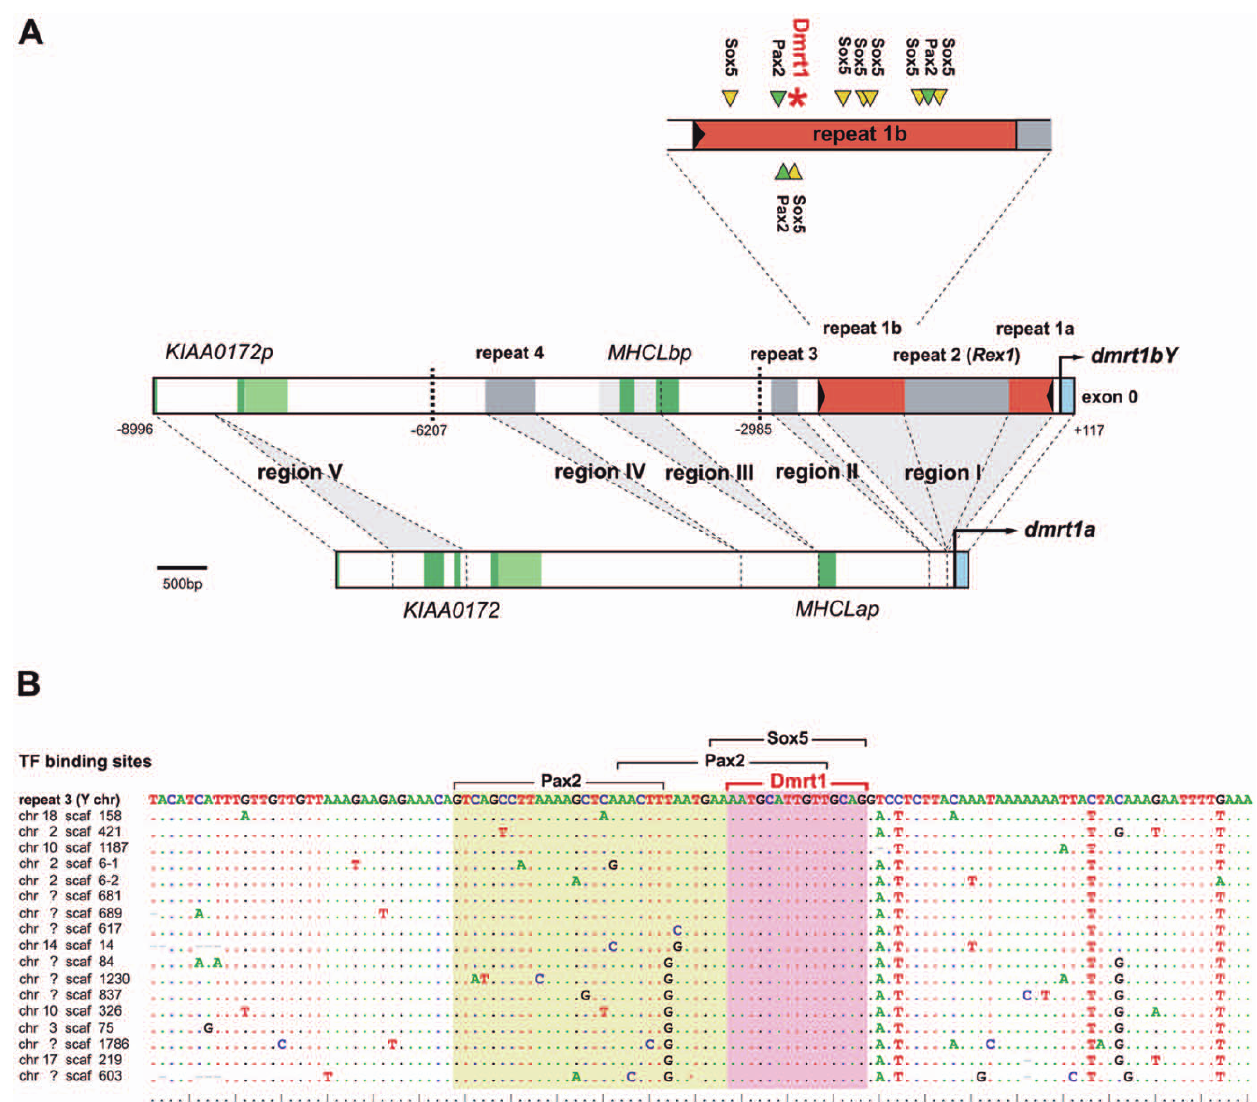
Figure 1. Comparative analysis of the dmrt1bY promoter and its transcription factor binding sites. (A) The analyzed promoter region of dmrt1bY in comparison to its dmrt1a paralog. Length differences between the promoters are based on regions I–IV, of which three (I, II, IV) have been added to the dmrt1bY promoter after duplication, while two others have been lost from the dmrt1bY promoter ( KIAA0172 region V) or from the dmrt1a promoter ( MHCLp region III), respectively. Bold dashed lines indicate cutting sites for transcriptional regulation analyses. Region I contains a putative Izanagi DNA transposons (repeat 1), into which a Rex1 element (repeat 2) was inserted secondarily. The upstream part of split repeat 1 (repeat 1b) in the dmrt1bY promoter contains multiple Sox5 and Pax2 binding sites as well as a Dmrt1 binding site. Dark green indicates coding sequence of genes and pseudogenes, light green indicates their untranslated regions. (B) Alignment of the Y chromosomal repeat 1b with 17 exemplary repeat copies in the medaka genome. Dots indicate conserved sites. The Dmrt1 binding site is perfectly conserved suggesting that it is an integral part of repeat 1 elements. All 28 copies of repeat 1b in medaka with the Dmrt1 binding sites are listed in Table S1.